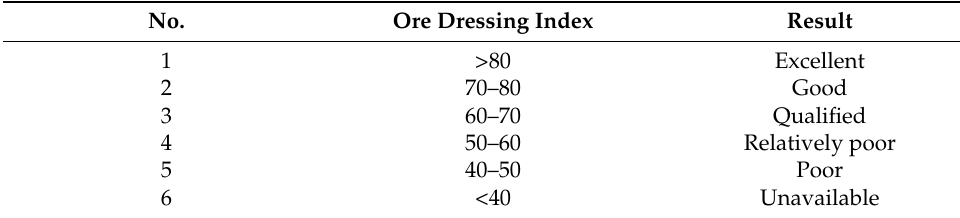
Table 7. Quality evaluation method of mixed ore.